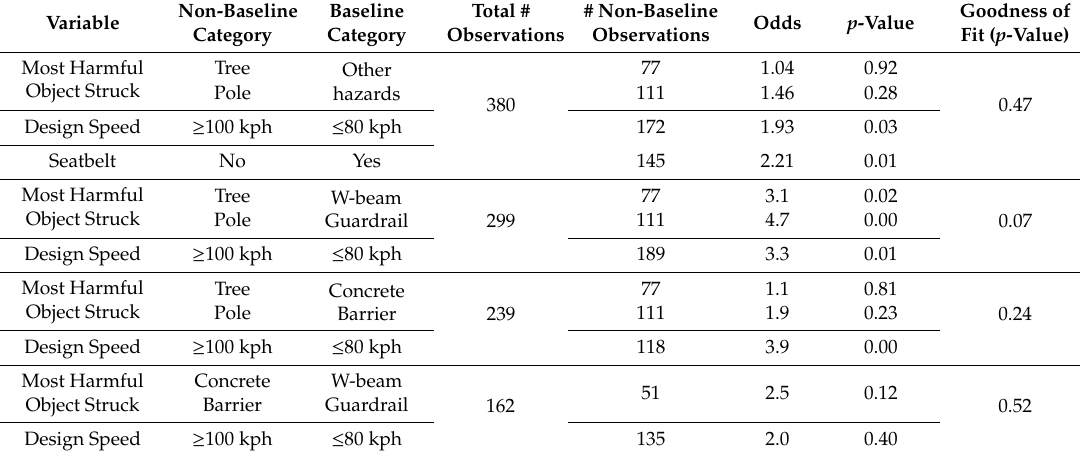
Table 4. Multivariate Analysis